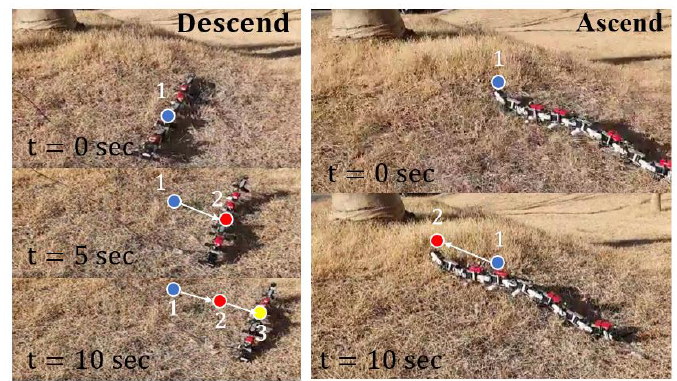
Figure 18. Performance of vertical motion with the DAM in rough terrain.